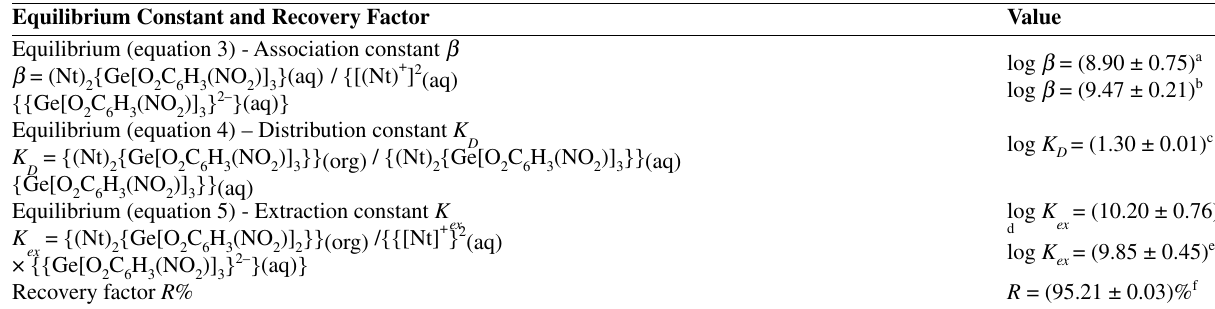
Table 3. Values of the Equilibrium Constants and the Recovery Factor Equilibrium Constant and Recovery